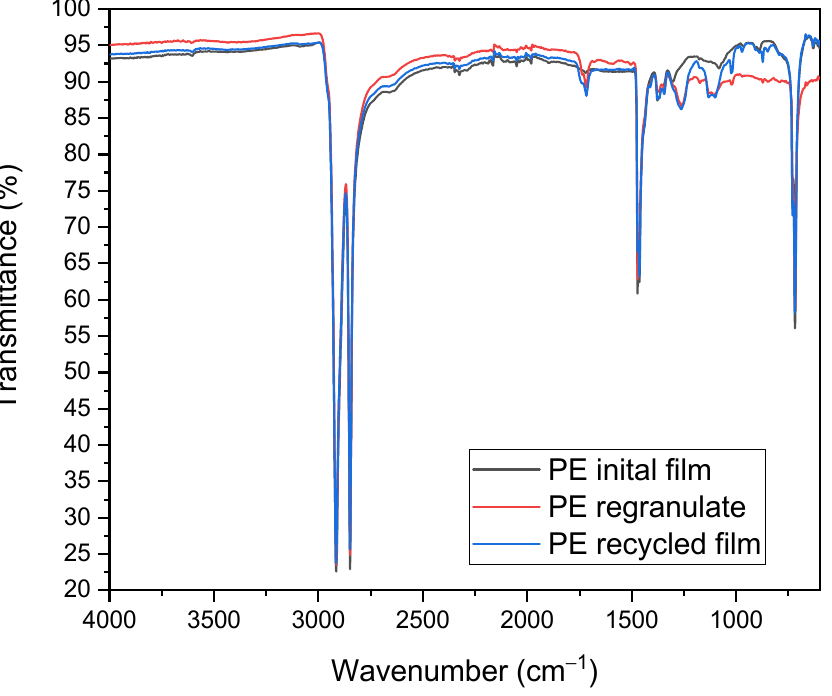
Figure 13. FTIR spectrum of the commercial LDPE film used to make the laminate, the LDPE regranulate, and the recycled film.